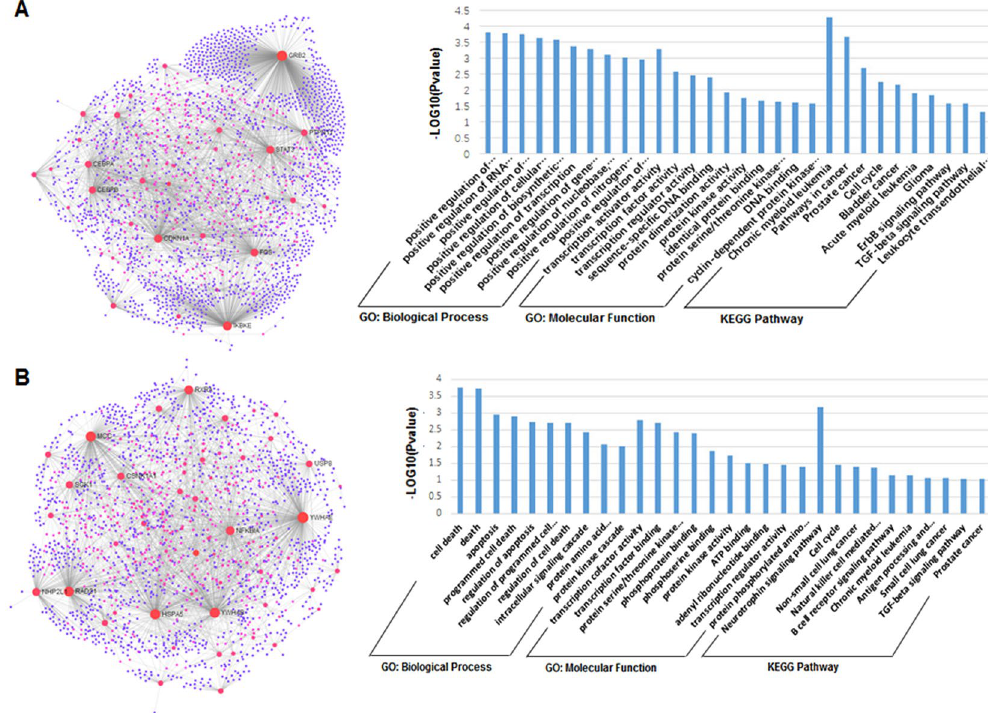
Figure 7. The visualization and functional analysis of KSHV miRNA-regulated CePPIN on common targets and specific targets. ( A ) CePPIN and functional analysis on common targets. ( B ) CePPIN and functional analysis on specific